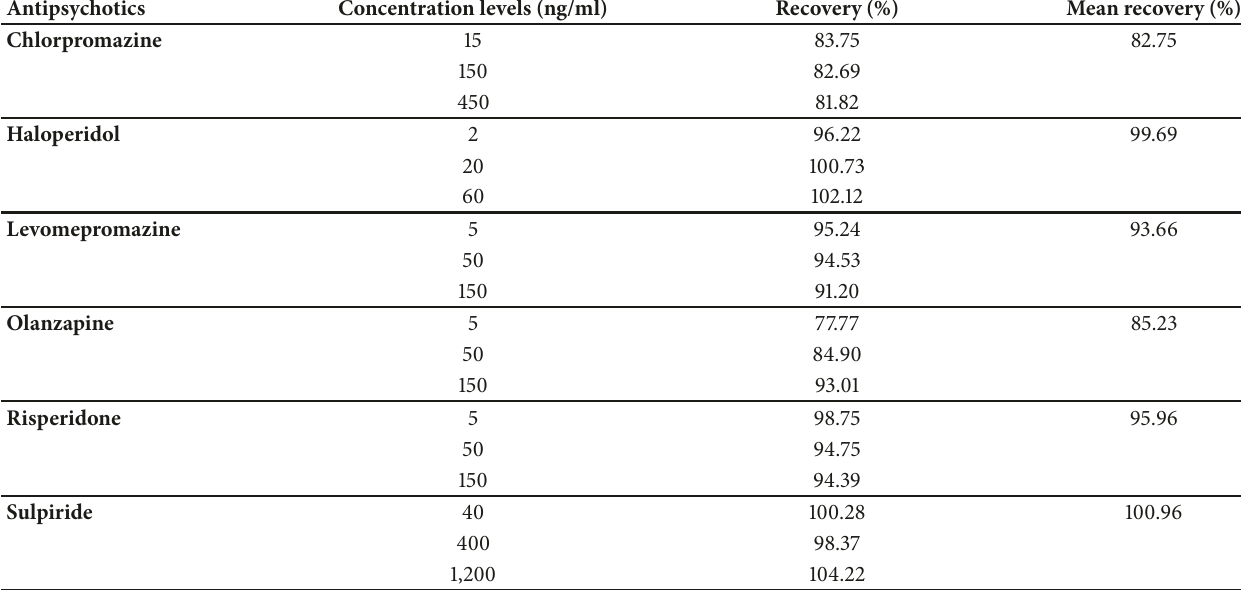
Table 3: Recovery values at low, medium, and high levels.